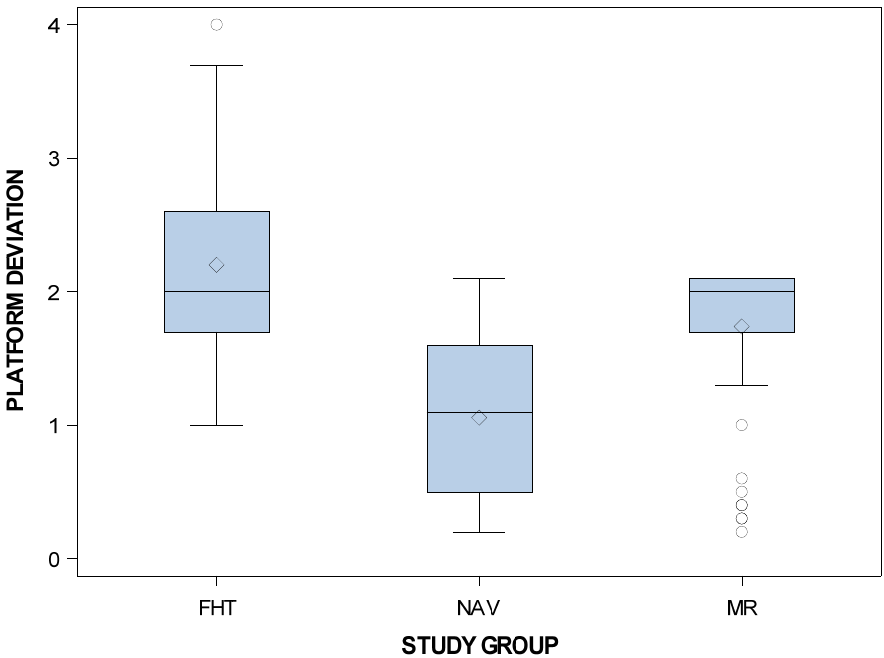
Figure 5. Box plot of the coronal deviations in planned and placed orthodontic micro-screws comparing the computer-aided static navigation technique, mixed reality technique and conventional freehand technique study groups. Table 2. Descriptive deviation values at coronal entry-point (mm) of the orthodontic micro-screws placed by using conventional freehand technique, mixed reality technique and computer-aided static navigation technique study groups in the incisive-canine, premolar and molar dental